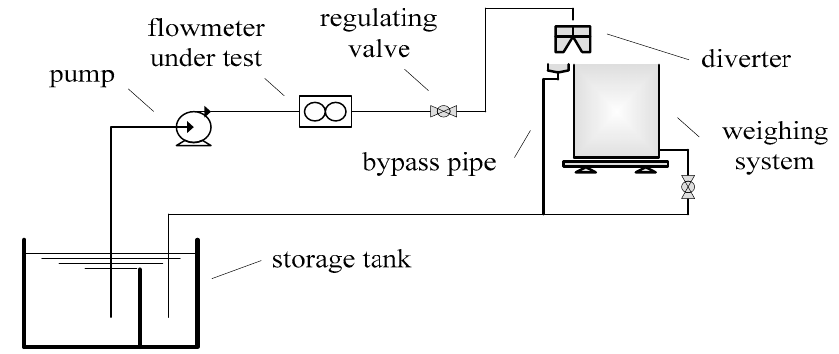
Figure 7. Schematic diagram of the water flow facility.